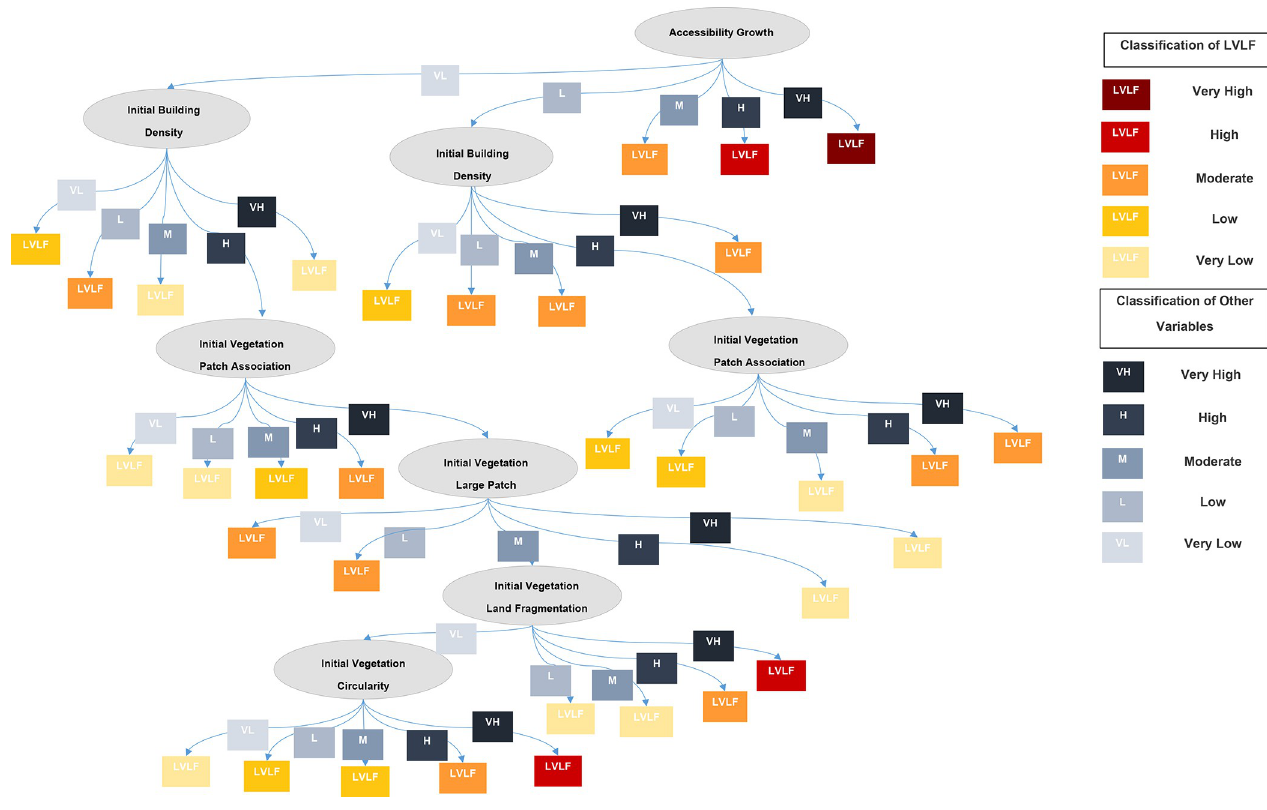
Fig 12. DT results of the LVLF model.